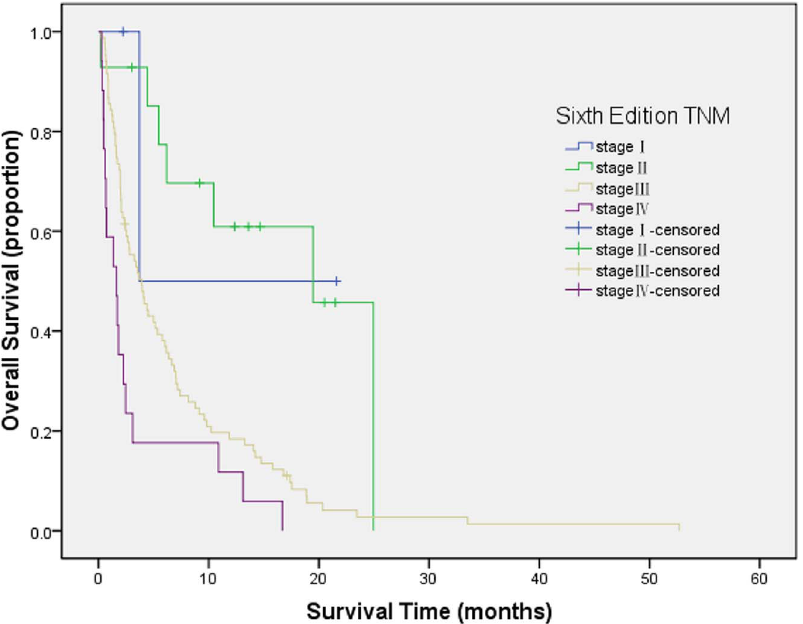
Figure 1. Survival curves for patients with unresectable hepatocellular carcinoma who were stratified according to the TNM sixth edition staging system. Stage I versus II, P=.704; stage II versus III, P=.009; stage III Versus IV, P=.000. The difference between stage I and II was not statistically significant.